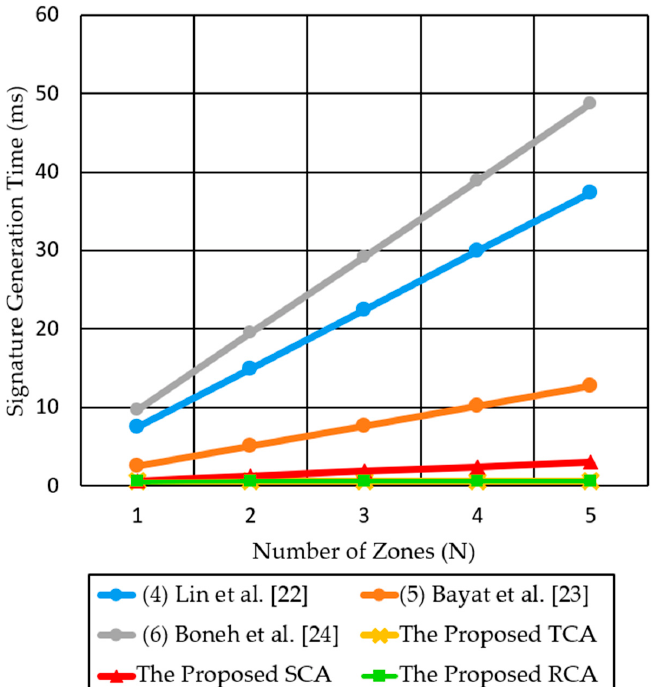
Figure 14. Comparison of signature generation time for the three proposed authentication methods and the two previous methods for multi-zone scenarios.